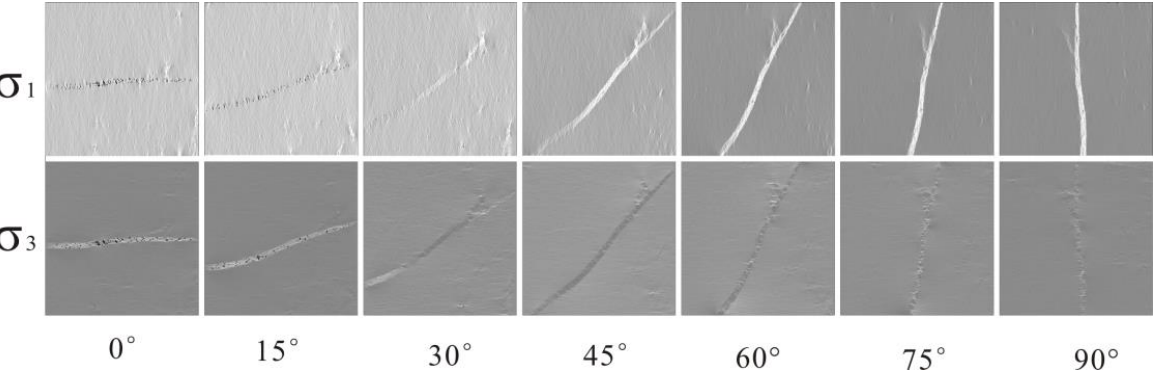
Figure 6. Stress distribution of coal with stress level of 10%.